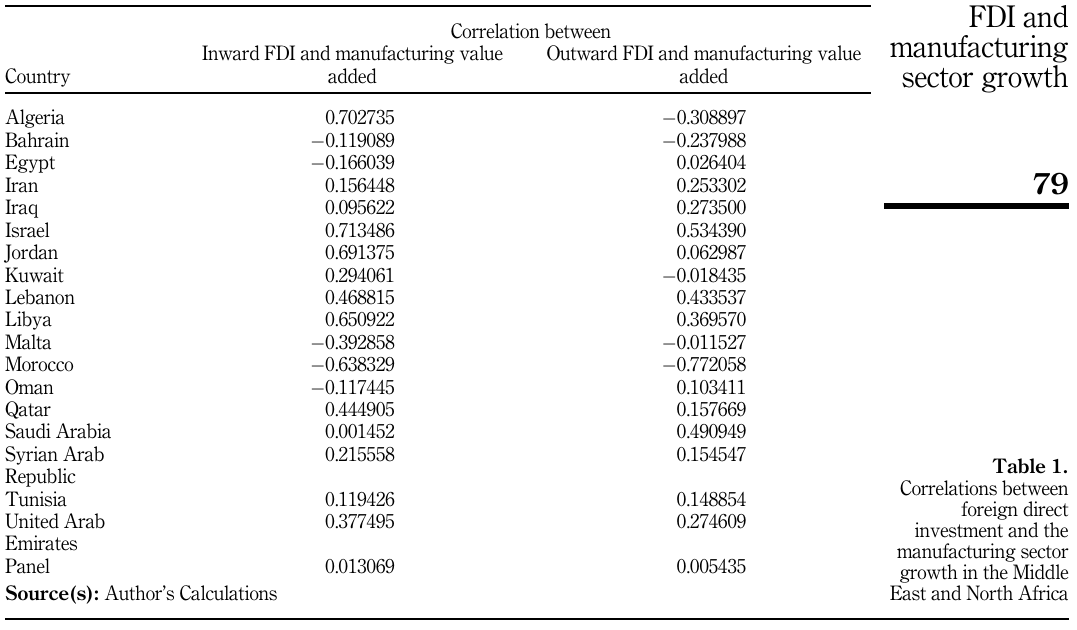
Table 1. Correlations between